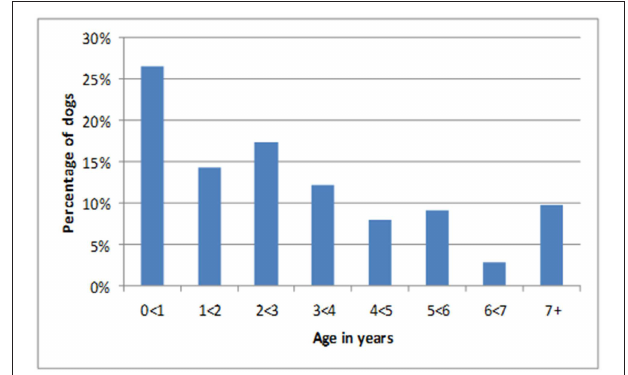
FIGURE 2 | Age distribution for all dogs at